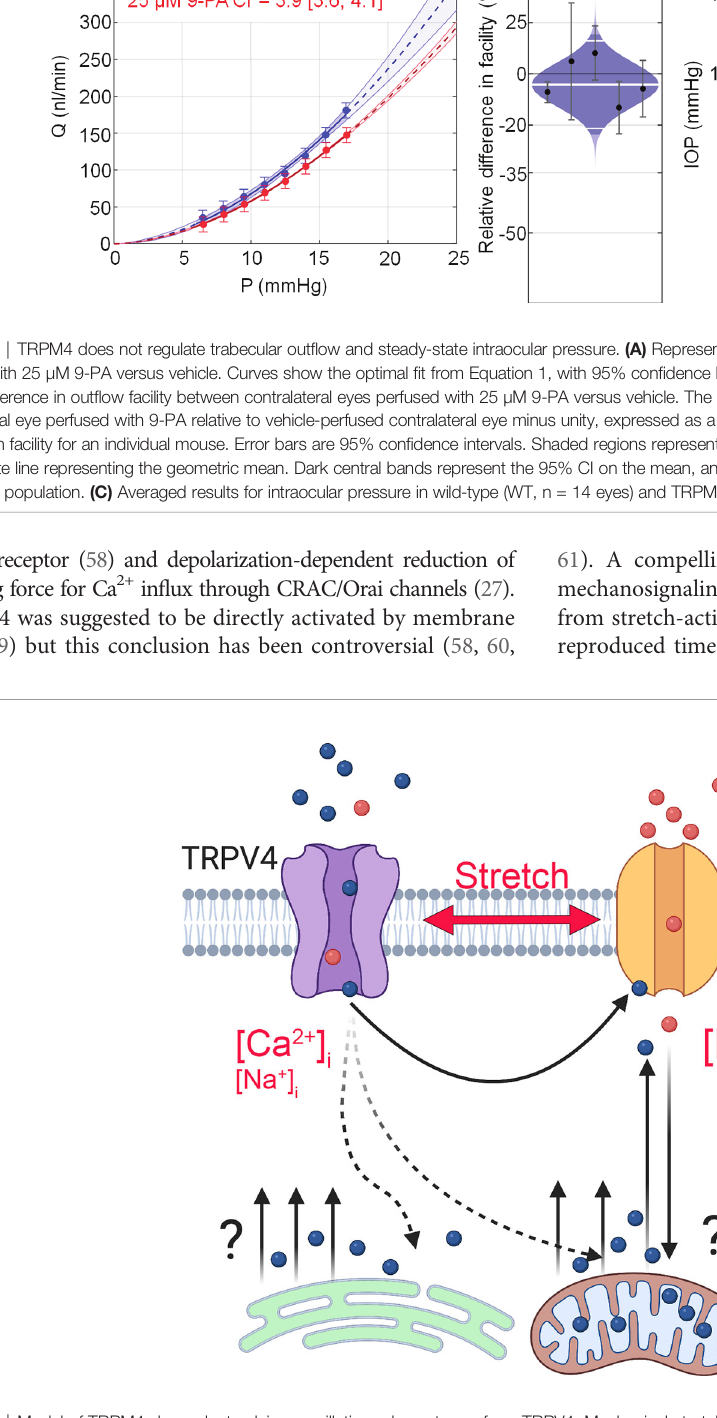
FIGURE 9 | Model of TRPM4-dependent calcium oscillations downstream from TRPV4. Mechanical stretch triggers cation in fl ux through TRPV4 to elevate [Ca 2+ ] i and activate TRPM4, a Ca 2+ -dependent Na + channel to depolarize the TM cells and increase [Na + ] i . TRPM4 activation is required for voltage-independent oscillatory release of Ca 2+ from a yet-unknown intracellular